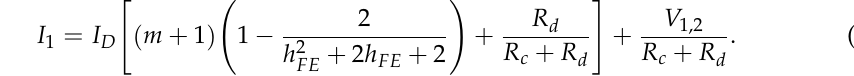
Figure 5. Two-terminal NDR circuit with multiple-output improved Wilson current